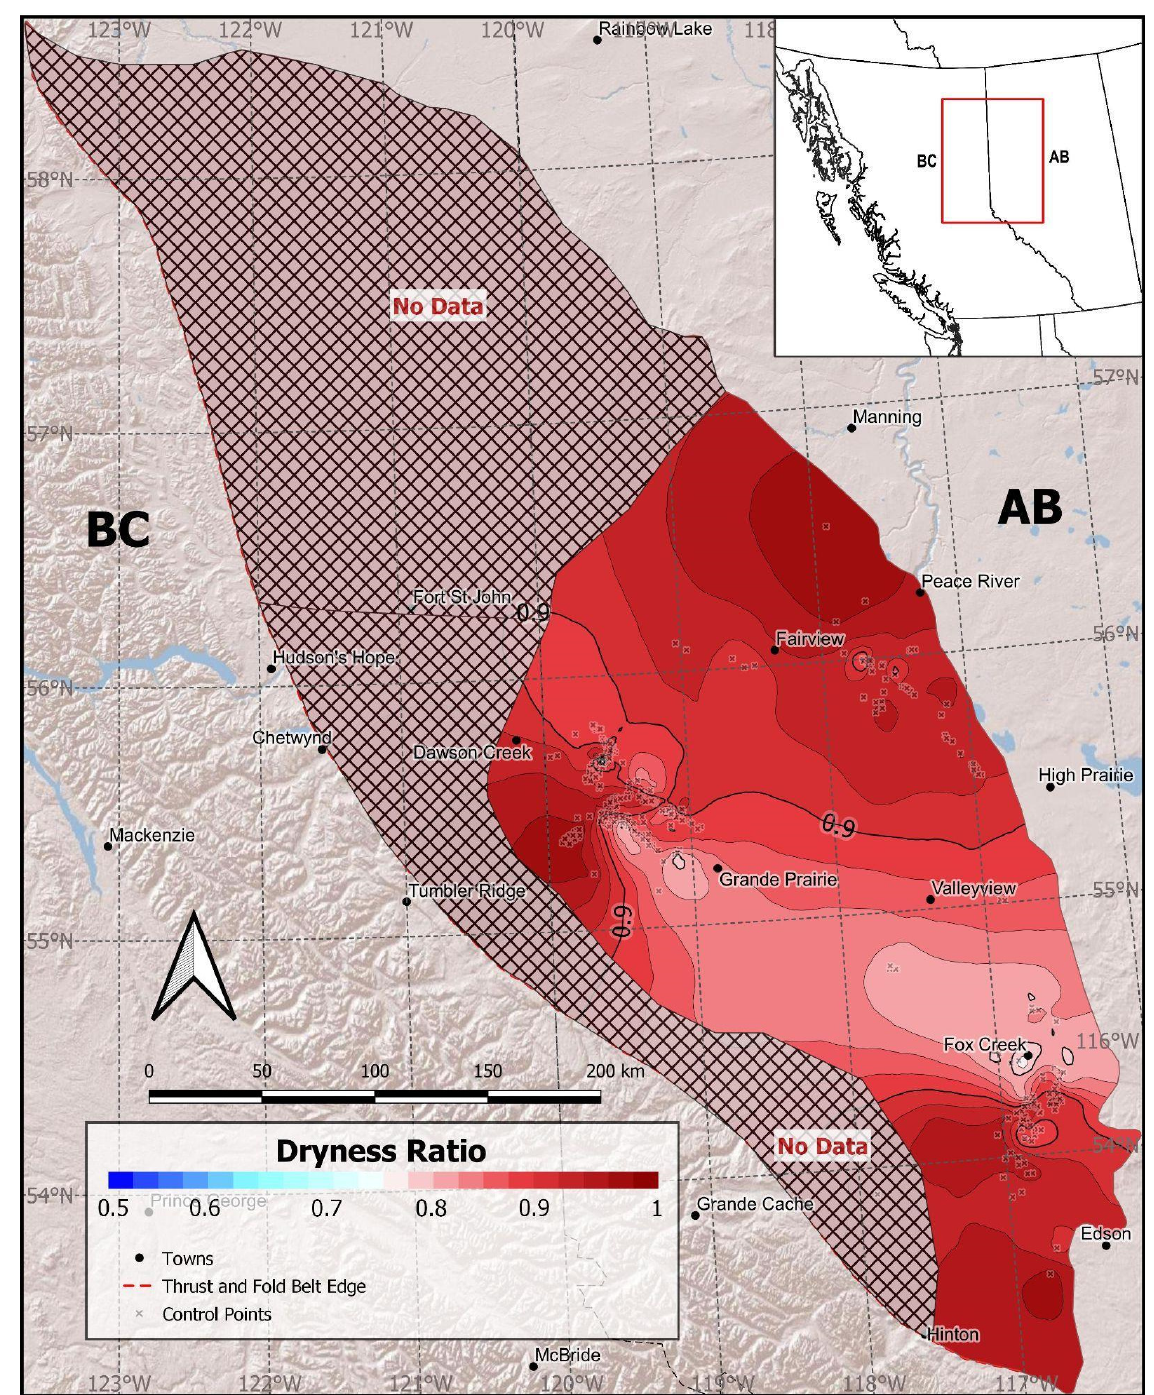
Figure 25. The distribution of the gas dryness ratio for the Lower Montney Formation. A similar gas dryness pattern was observed from individually mapping the Upper and Middle Montney Formation subzones.